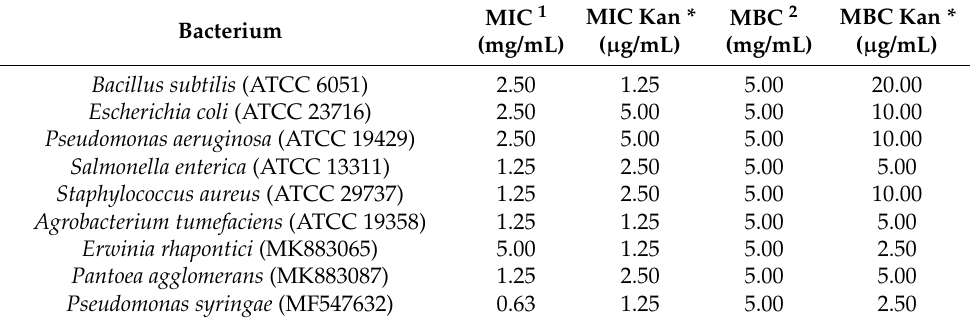
Table 4. Antibacterial activity of P. peruviana from the Arid Andean Region of